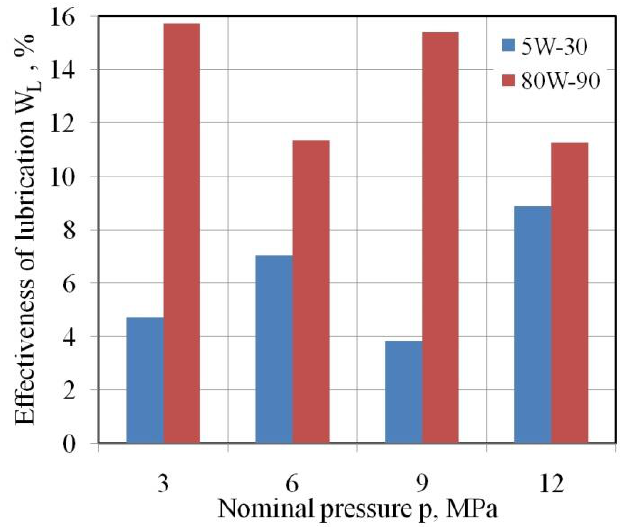
Figure 10. Effect of nominal pressure on the effectiveness of lubrication.